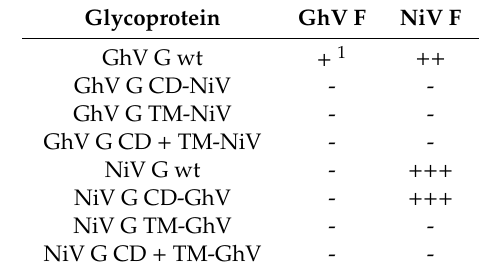
Size of syncytia is indicated as the maximal number of nuclei per syncytium from three coverslips. (-) = no syncytia detected; ( + ) = ≤ 5 nuclei per syncytium; ( ++ ) = 5–10 nuclei per syncytium; and ( +++ ) = ≥ 10 nuclei per syncytium. 1 Fruit bat cells